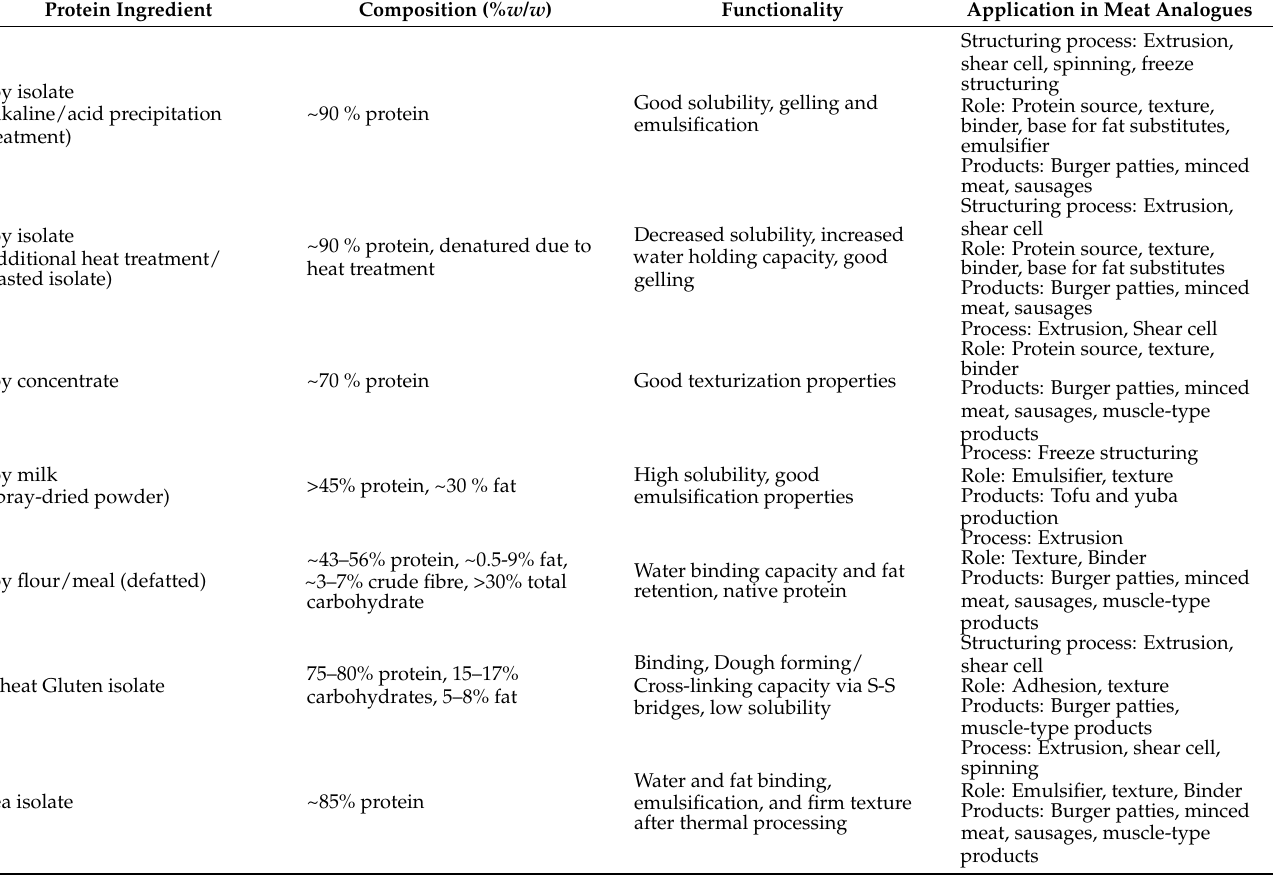
Table 1. Summary of already used protein ingredients for meat analogue